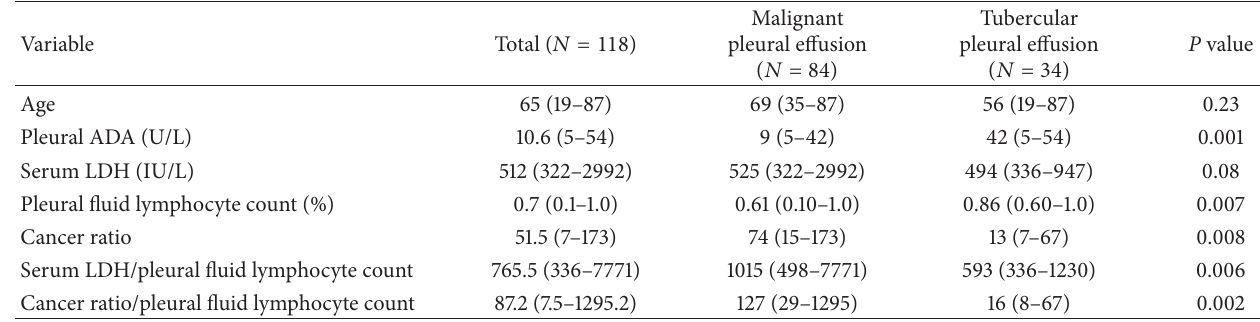
Table 1: General characteristics and univariate